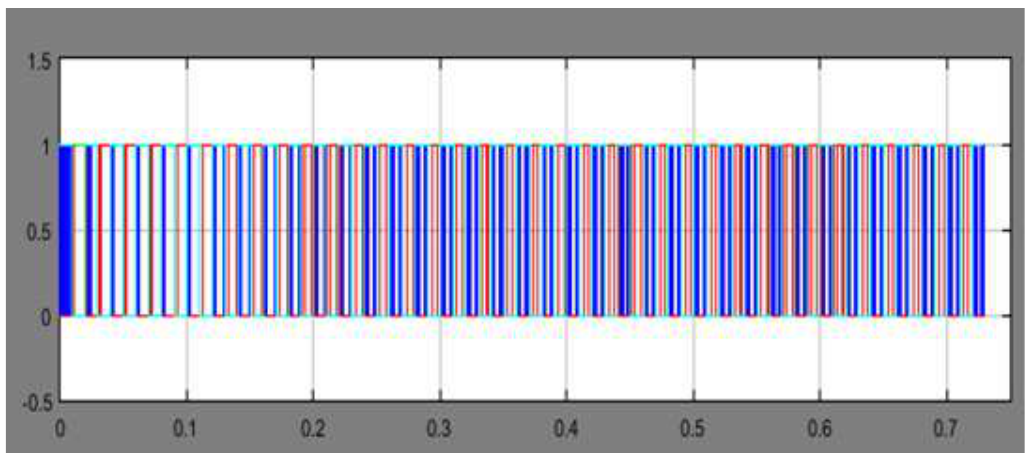
Figure 16. PWM control signal.